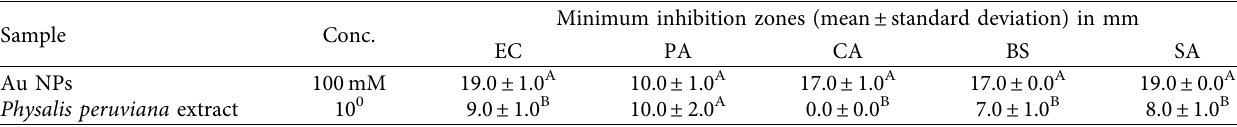
Table 2: Comparison of minimum inhibition zones of aqueous Au NPs at 100mM with the aqueous Physalis peruviana extract.